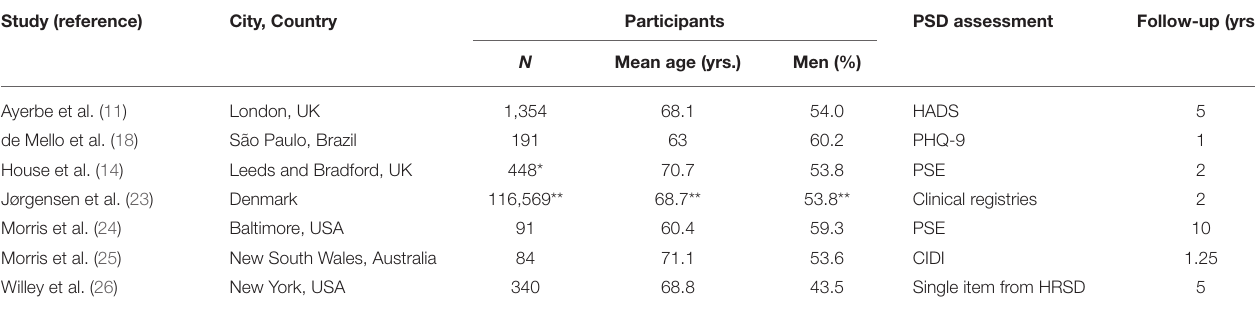
TABLE 1 | Characteristics of included studies.